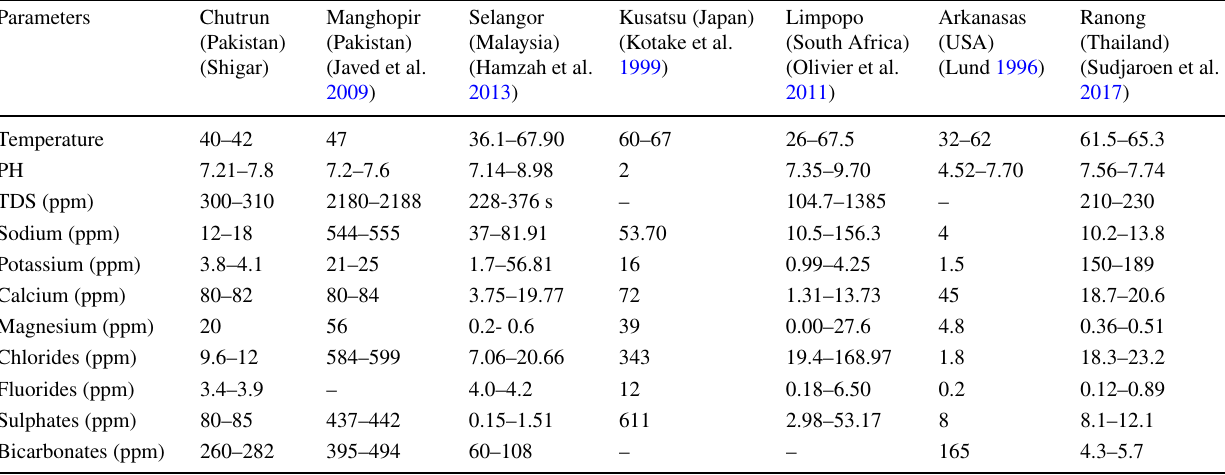
Table 5 Physico-chemical comparison between Chutrun hot springs and world’s renowned thermal springs